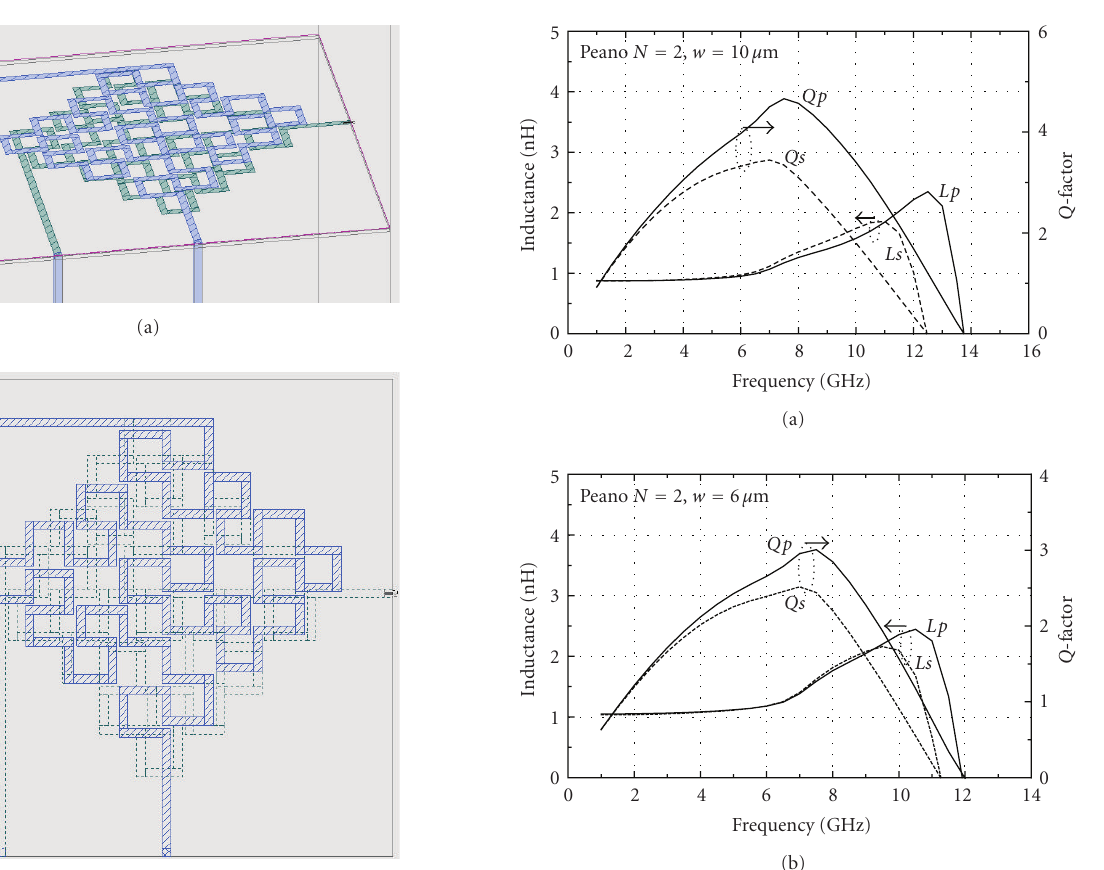
transformers with square spiral geometry. The presented results mean that transformer configurations with